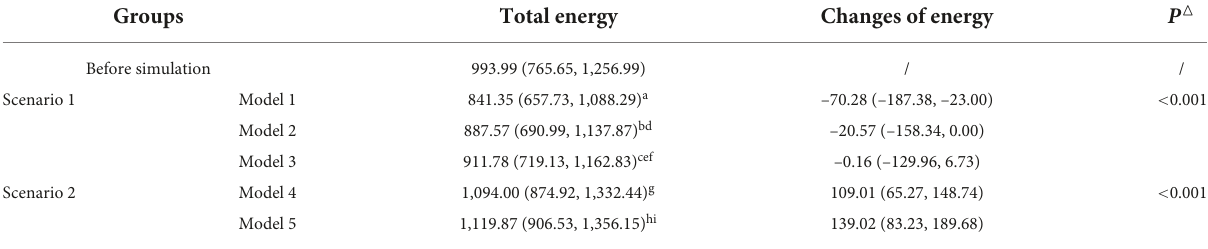
TABLE 2 Total energy intake after simulation ( n = 676) [ P 50 ( P 25 , P 75 )] (kcal/d).